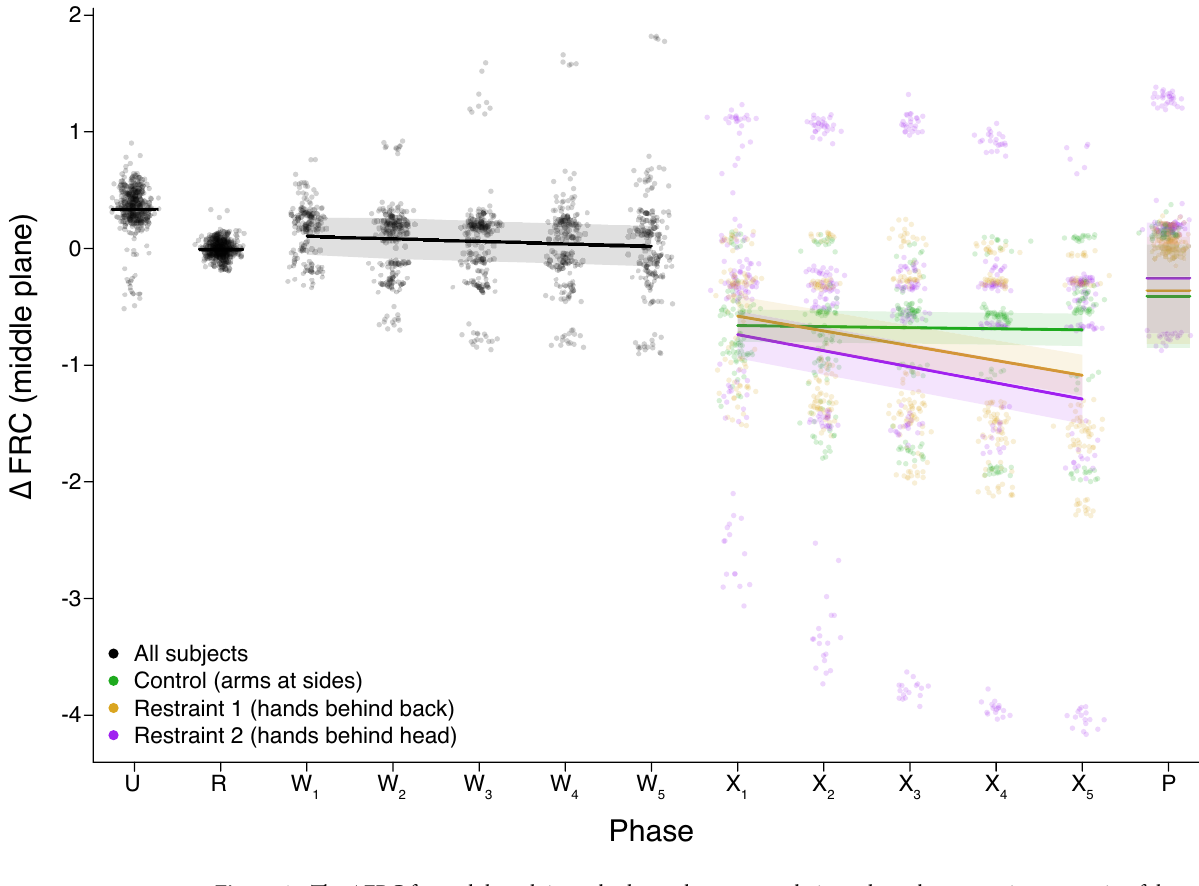
Figure 4. The (cid:31) FRC for each breath in each phase, shown as a relative volume by expressing as a ratio of the mean phase R V T , for the middle imaging plane. The solid lines are predicted means derived from the statistical analyses assuming the average age and BMI. The shaded regions show the 95% confidence interval on these model predictions. Postures were either a control posture identical to that of phase W, with arms at the side (N = 5), hands clasping each other on the small of the back (N = 6), or both hands on the back of the head (N = 6). Note that in phase P, the number of subjects was reduced to only N = 1 (control), N = 3 (hands-back) and N = 3 (hands-head).